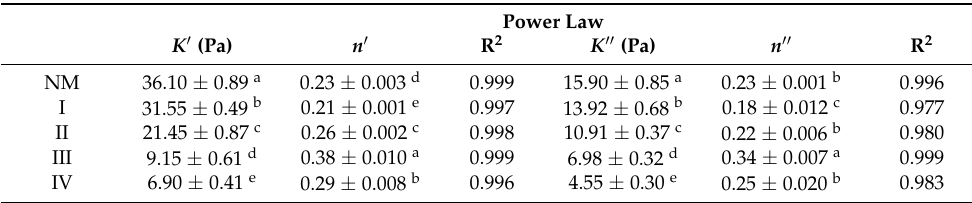
Table 6. The Power Law model parameters fitting results of frequency dependence of native oats and in four extrusion